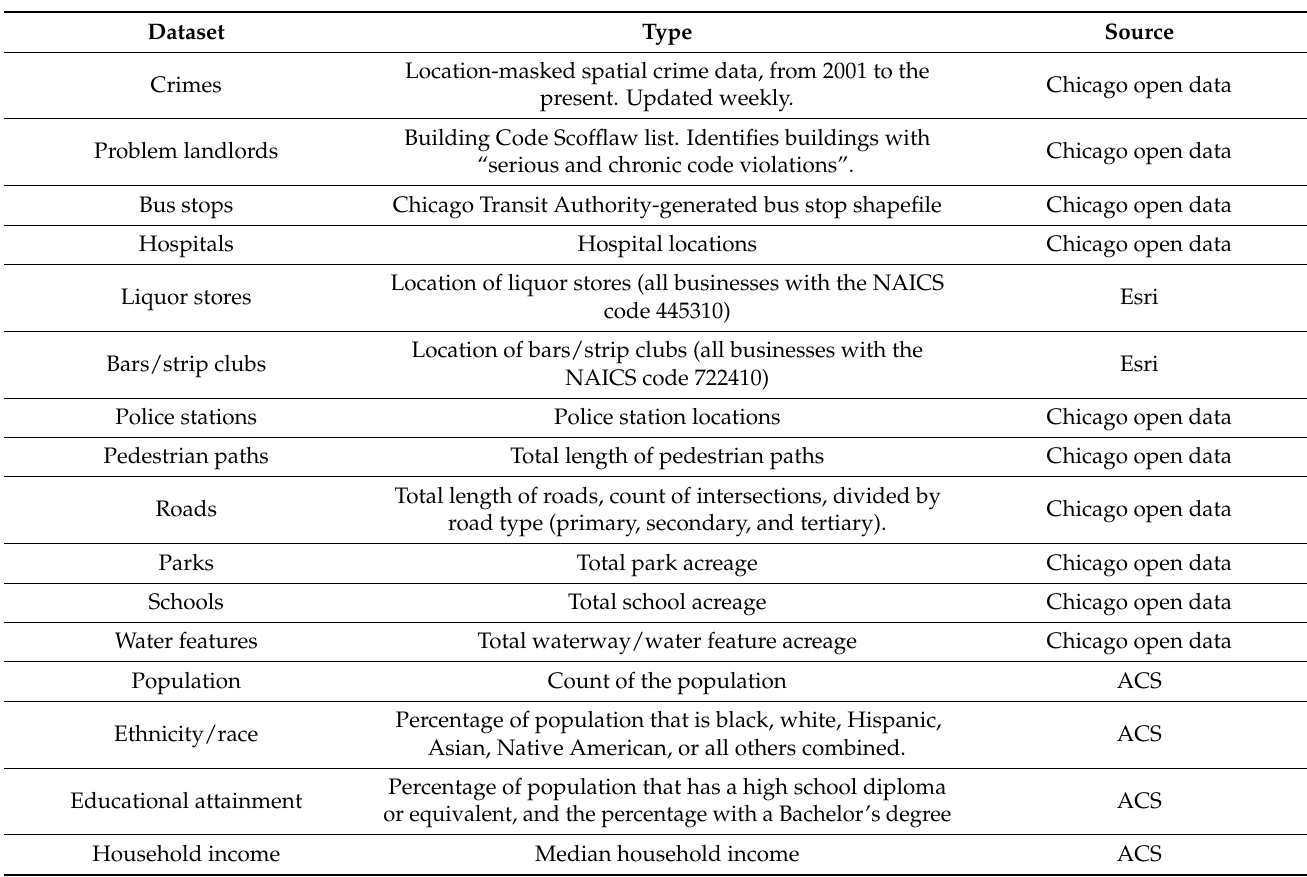
Table 1. List of the datasets used to develop the models in this